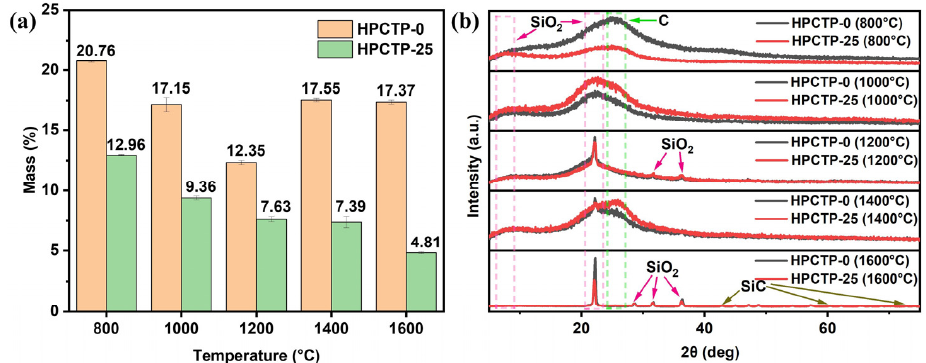
Figure 12. Static ablation of HPCTP-0 and HPCTP-25 at different temperatures in a tube furnace: ( a ) residual mass percentage; ( b ) XRD patterns of carbon residue.